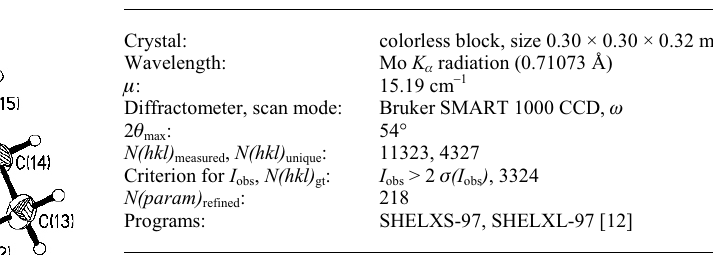
Table 1. Data collection and handling.